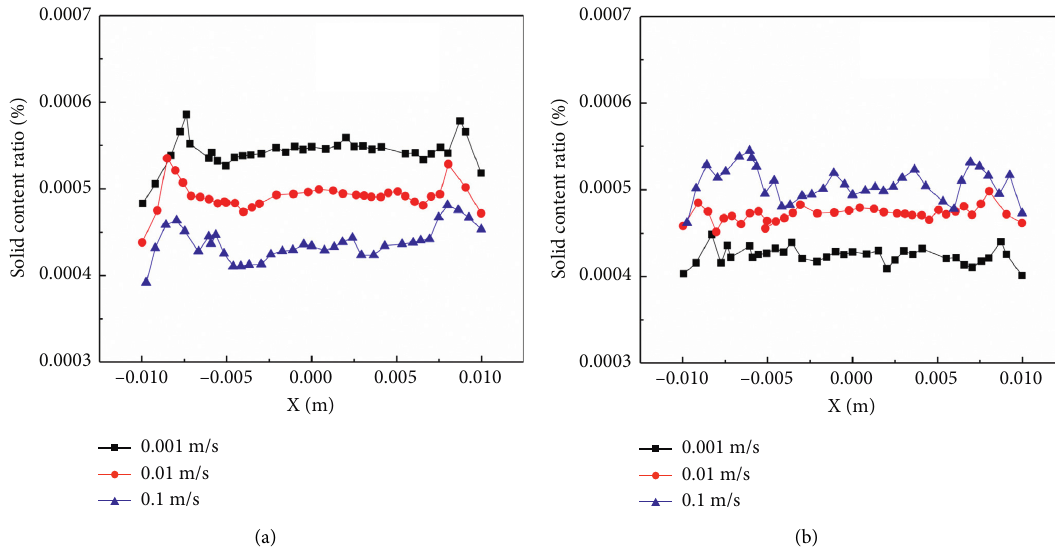
Figure 5: Influence of crude oil flow velocity on the distribution of nanomagnetic enzymes. (a) Solids holdup of nanomagnetic enzyme particles at the height of 75mm. (b) Solids holdup of nanomagnetic enzyme particles at the height of 225mm.